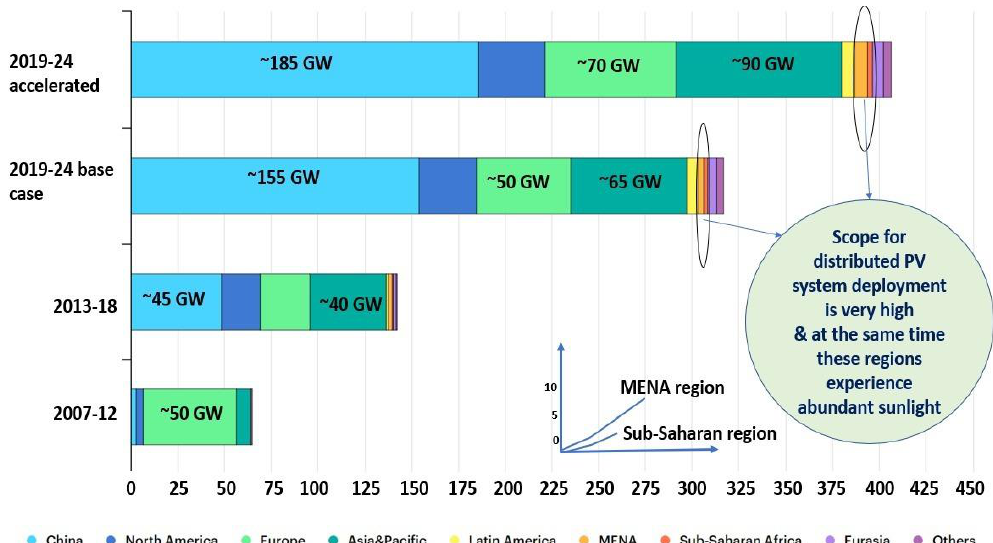
Figure 5. Distributed solar photovoltaic capacity growth by country/region showing the scope for future deployment in the Middle-East and North Africa region, measured in gigawatts (GW) (Data source: International Energy Agency (IEA), Renewables 2019).